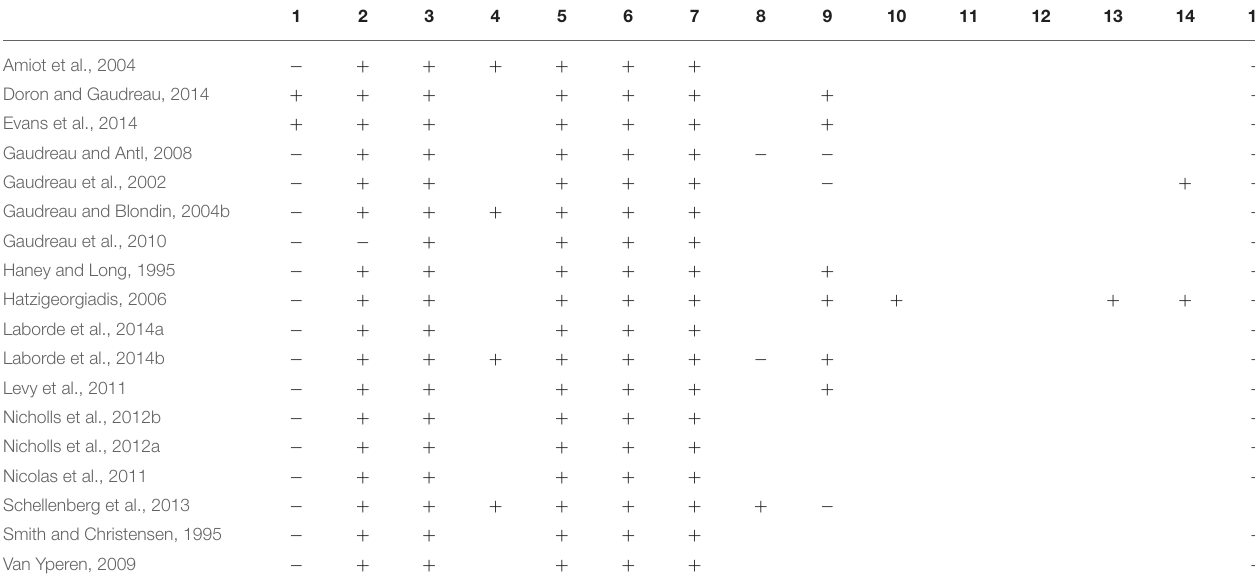
TABLE 1 | Risk of